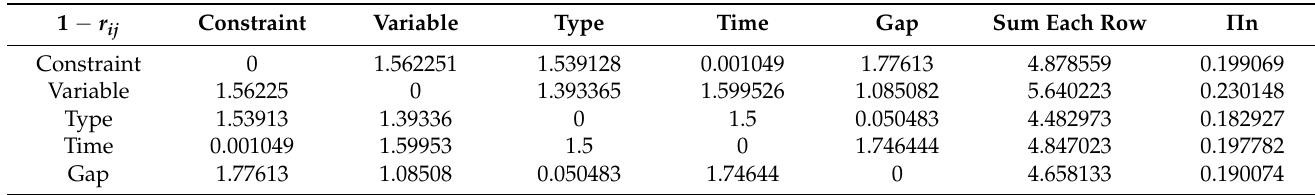
Table A4. Calculate π = Σ (1 − r ij ).